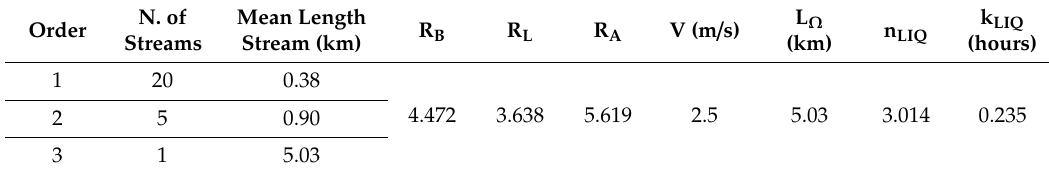
Table 4. Results from Horton–Strahler classification and estimated Nash parameters.